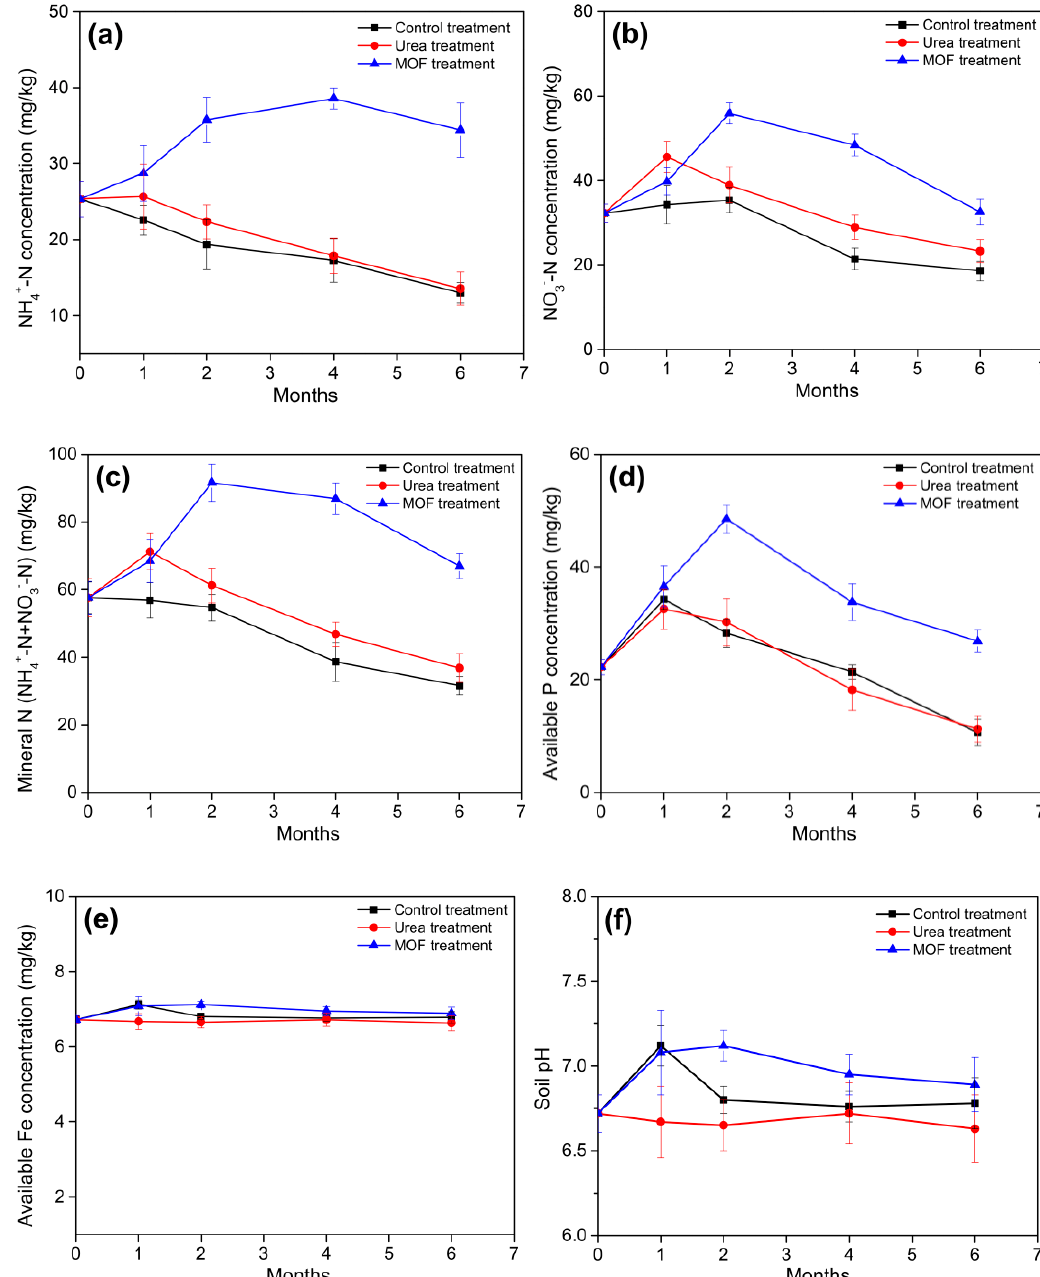
Figure 6. Effects of the MOF on soil nutrients. ( a ) NH 4+ -N; ( b ) NO 3 − -N; ( c ) mineral N (NH 4+ -N + NO 3 − - N); ( d ) available P; ( e ) available Fe; and ( f ) soil